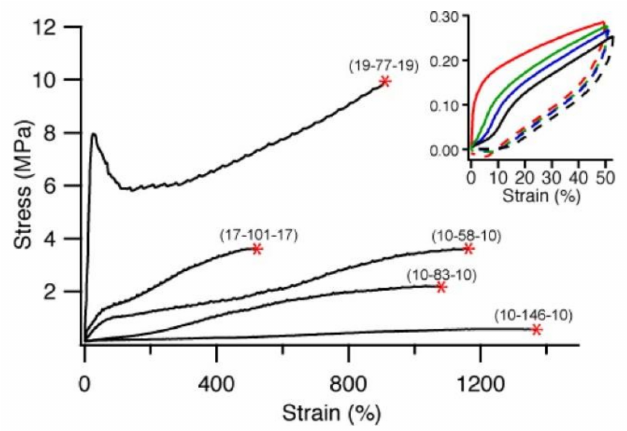
Figure 7. Representative stress-strain curves of poly ( α -methyl- p -methylstyrene- b -myrcene- b - α -methyl- p -methylstyrene) samples at room temperature (* Denotes failure point). Sample designation: The sets of numbers in brackets correspond to block sizes in kg mol − 1 ; inset shows stress recovery of the 17-101-17 block copolymer. (Reproduced from Reference 23, with permission from American Chemical